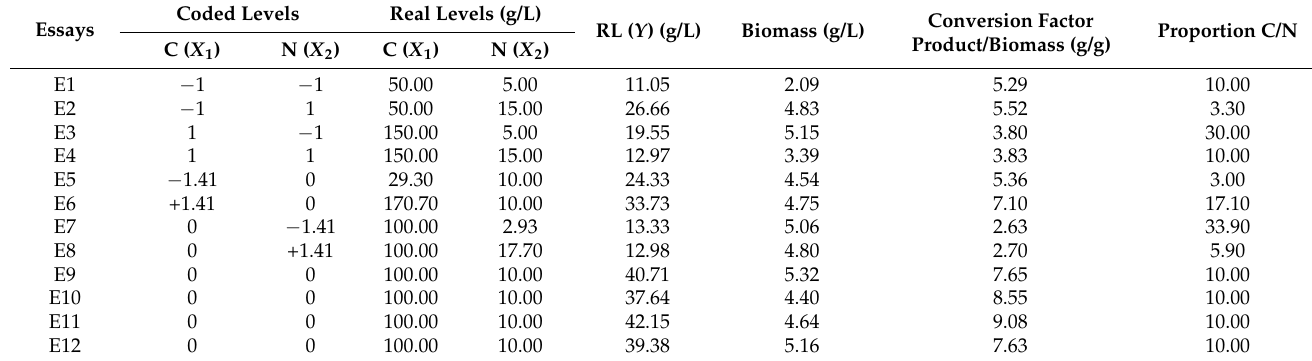
Table 2. Central composite rotational design used in cultivation of P. aeruginosa LBI 2A1. Media were composed of guava seed oil as carbon source and sodium nitrate as nitrogen source. Independent variables represented by coded and real levels. Responses correspond to 96 h of fermentation and show rhamnolipids, biomass, product/biomass conversion factor and carbon/nitrogen ratio in each